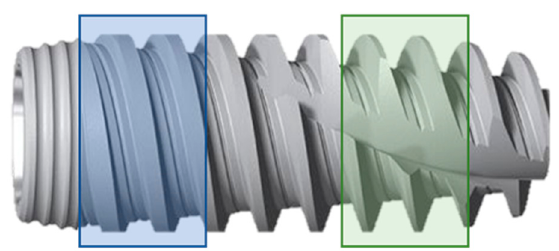
Figure 1. Regions of interest of the surface characterization. Morphological and compositional measurements zone (blue rectangle). Roughness analysis zone (green rectangle).